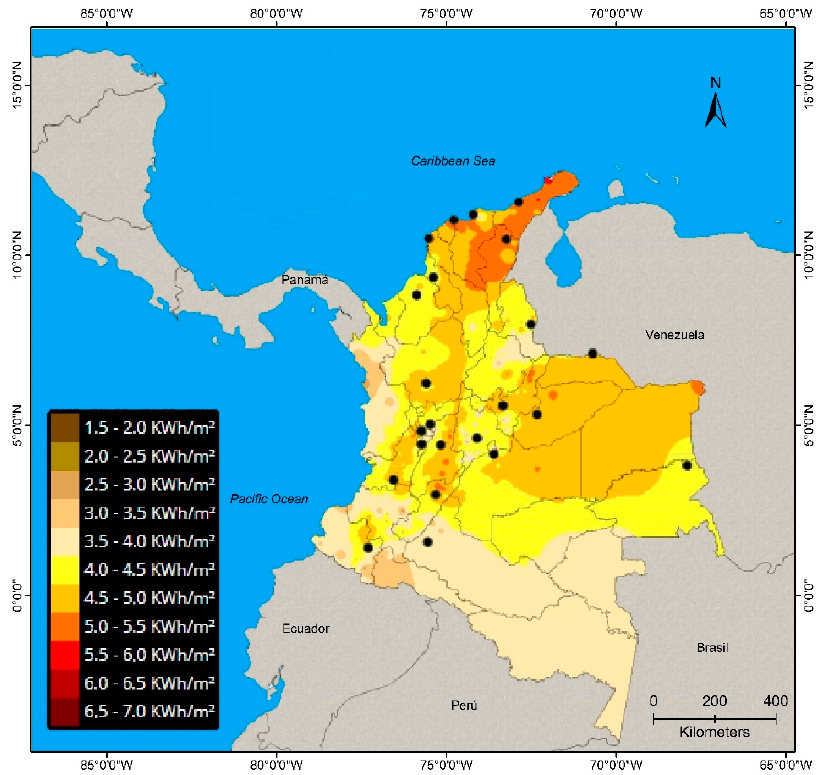
Figure 1. Annual average daily horizontal global irradiation in Colombia [3].